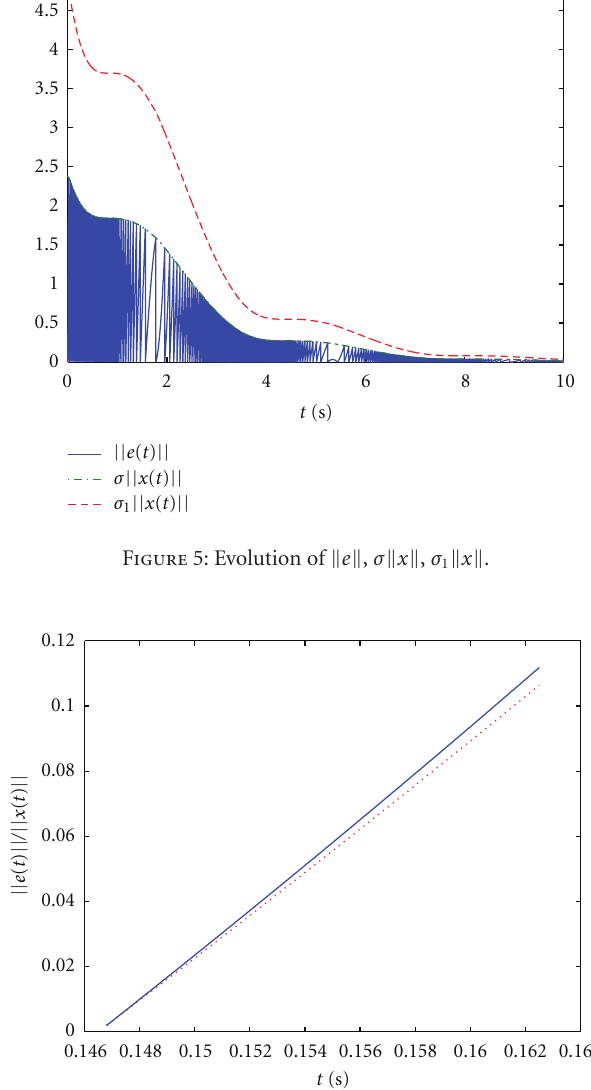
Figure 4: Evolution of V ( t ) for σ = 0 . 1064 and initial condition ( x 1 (0), x 2 (0)) = (10,20).